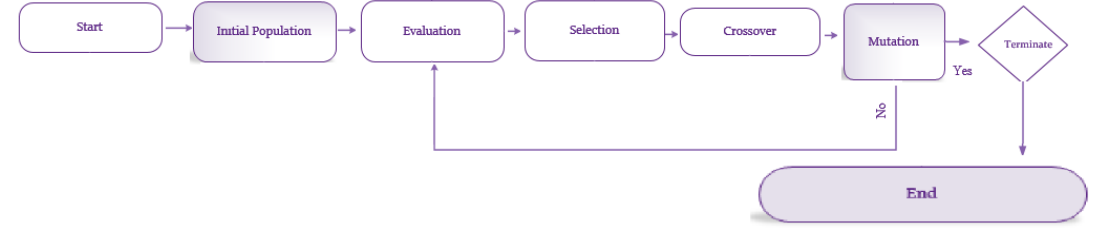
Figure 2. Genetic algorithm steps.